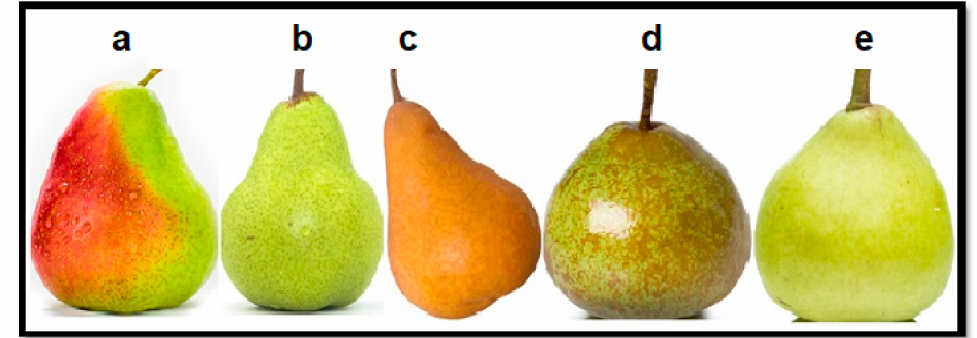
Figure 1. Australian grown pear varieties ( a ), Rico ( b ), Packham’s Triumph ( c ), Beurre Bosc ( d ) Winter Nelis and ( e ) Josephine de